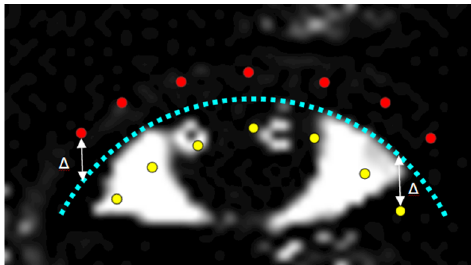
Figure 10. Eyelid shape matching (for the top eyelid only). The dotted line represents the current hypothesis; the positive pixels are depicted in yellow and the negative pixels in red.